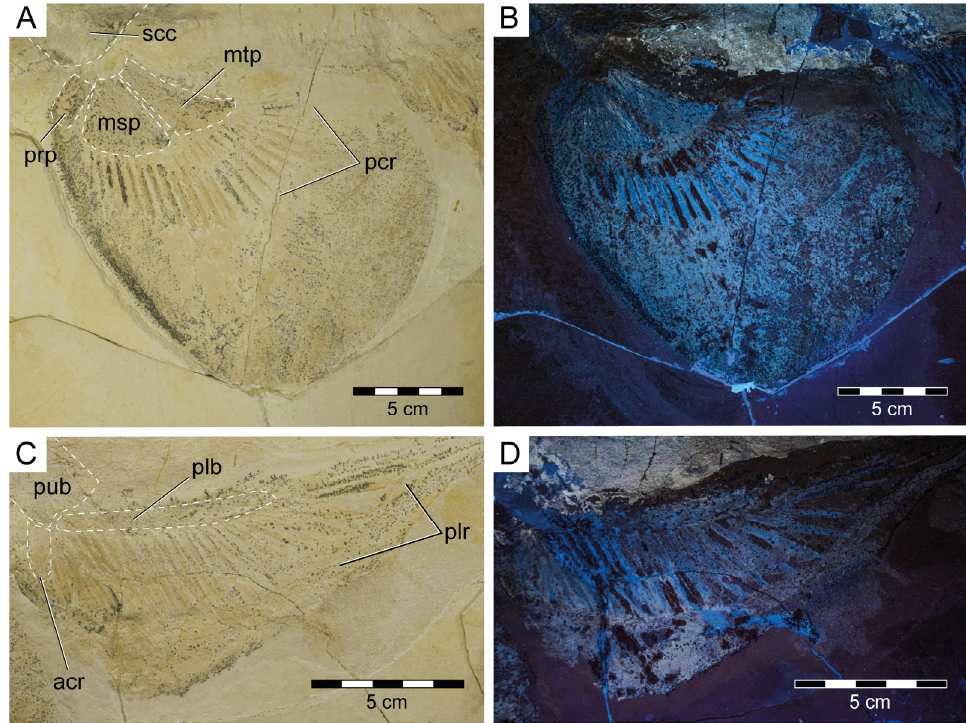
Figure 6. Pectoral and pelvic fins of Protospinax annectans Woodward, 1918, PBP-SOL-8007, from the lower Tithonian of the Solnhofen Archipelago, Bavaria, Germany. ( A ) pectoral fin under normal light; ( B ) pectoral fin under UV light; ( C ) pelvic fin under normal light; ( D ) pelvic fin under UV light. Abbreviations : acr , anterior compound radial; msp , mesopterygium; mtp , metapterygium; pcr , pectoral radial; plb , pelvic basipterygium; plr , pelvic radial; prp , propterygium; pub , puboischiadic bar; scc , scapulocoracoid.